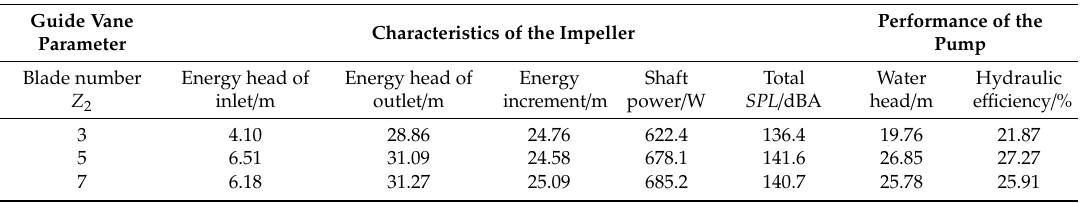
Table 6. Correlations between the number of guide vanes and hydraulic and hydroacoustic Correlations between the number of guide vanes and hydraulic and hydroacoustic characteristics of the impeller. characteristics of the impeller. Guide